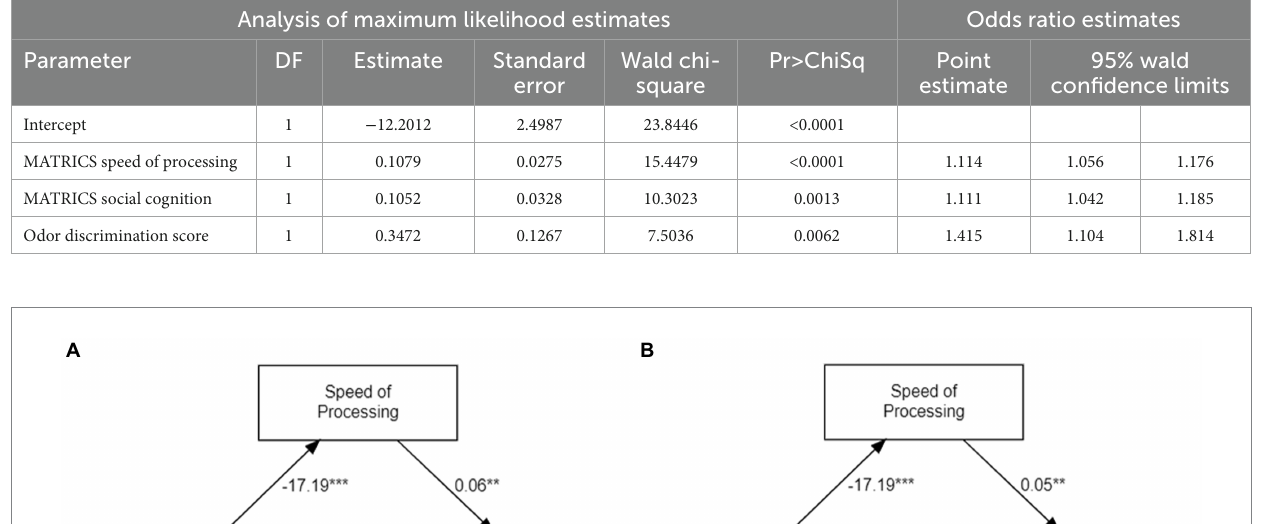
TABLE 8 Significant variables discriminating subjects with Schizophrenia from controls.